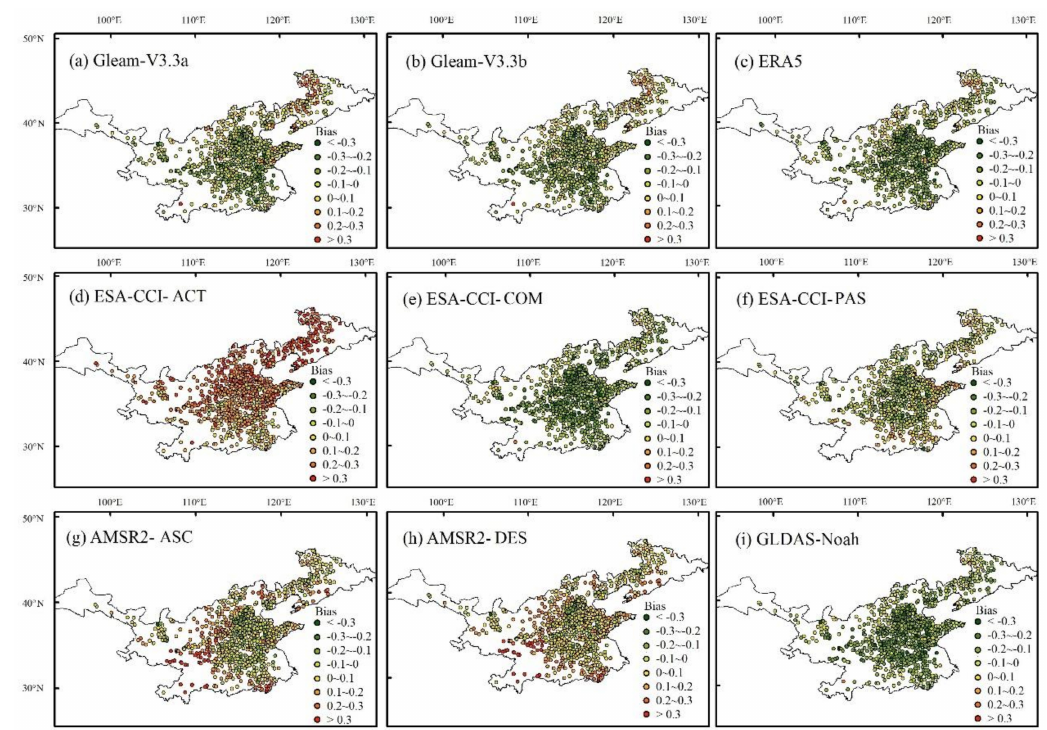
Figure 7. Spatial distribution of bias between multi-source SM products and in situ ground observations. Four classes are included in bias evaluation: [ − 0.1, 0) and (0, 0.1]; [ − 0.2, − 0.1) and (0.1, 0.2]; [ − 0.3, − 0.2) and (0.2, 0.3]; < − 0.3 and > 0.3.